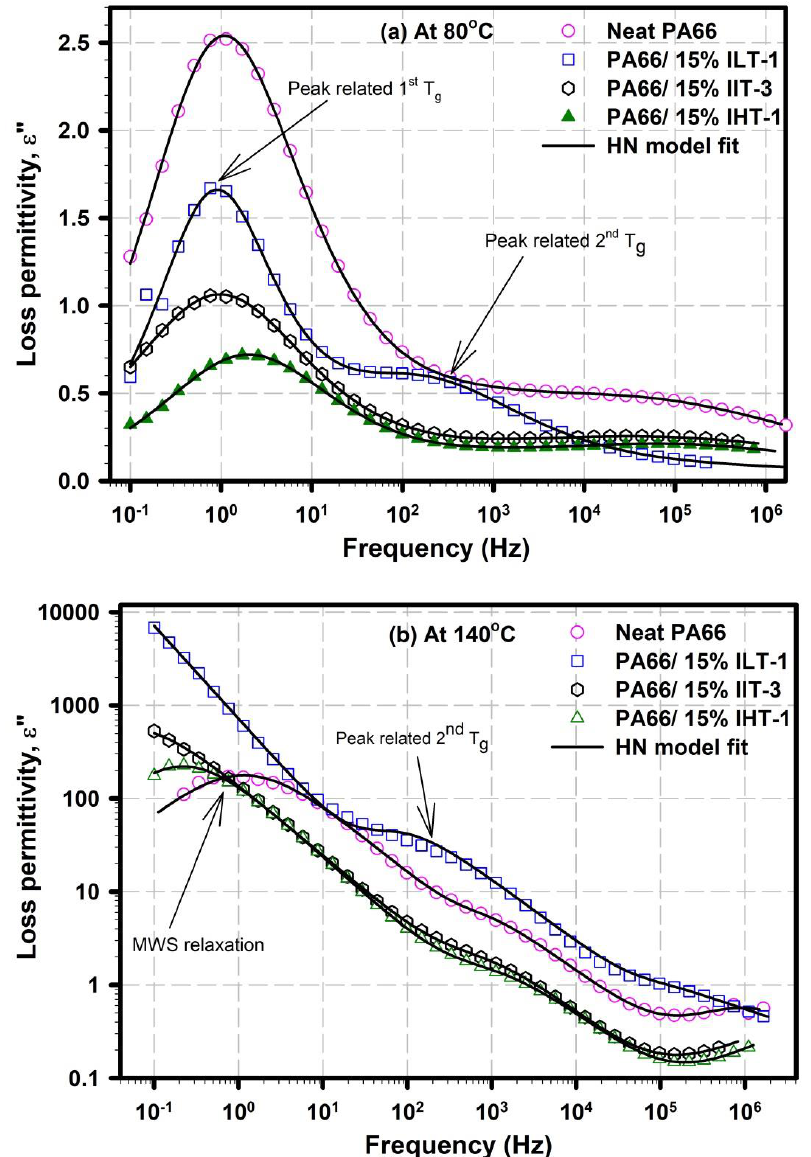
Figure 8. ε ″ vs. f spectra at a ) 80 and b ) 140 °C for PA66/P-glass systems and the processed virgin Figure 8. ε (cid:48)(cid:48) vs. f spectra at ( a ) 80 and ( b ) 140 ◦ C for PA66 / P-glass systems and the processed virgin PA66 showing the α relaxation. Lines show the HN equation fits to the spectra. PA66 showing the α relaxation. Lines show the HN equation fits to the